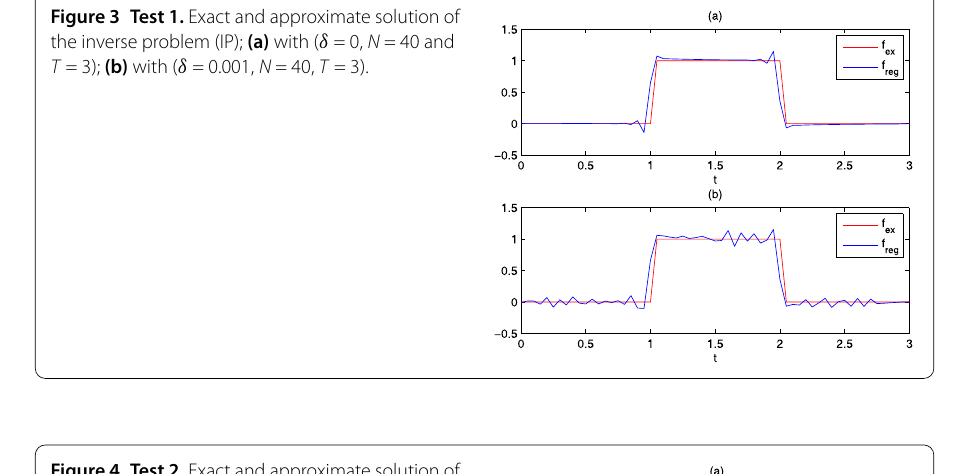
Figure 4 Test 2. Exact and approximate solution of IP; (a) with ( δ = 0, N = 40, T = 3); (b) with ( δ = 0.001, N = 50, T = 3).